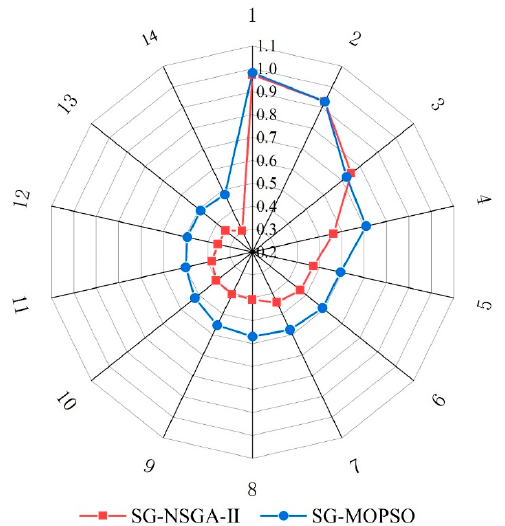
Figure 6. Comparison of the efficiency values of the results.